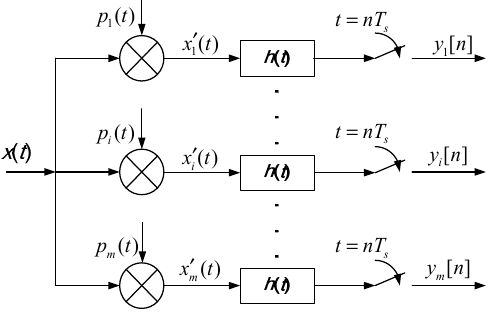
Figure A1. MWC under-sampling system.